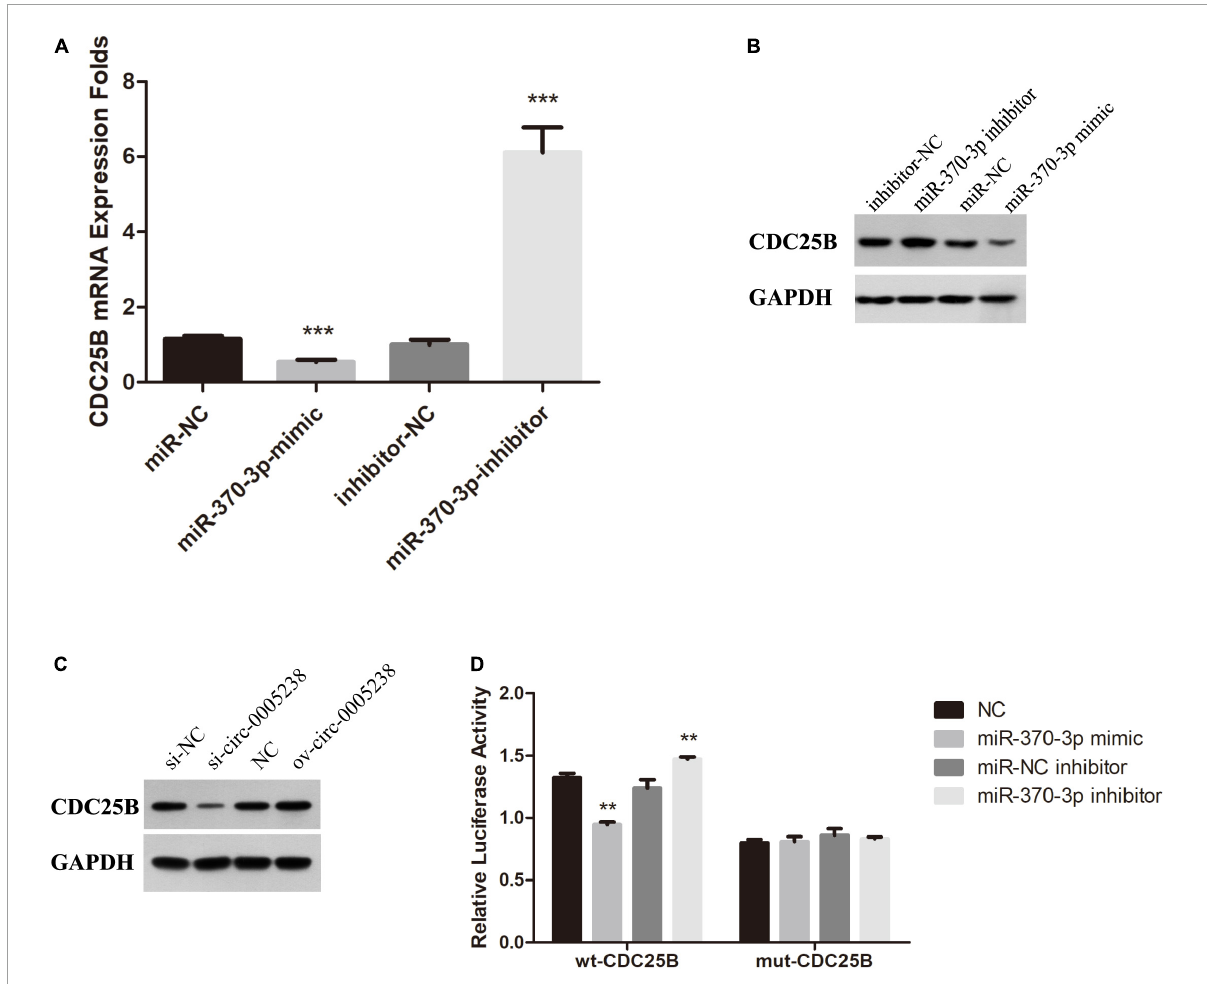
FIGURE9 CDC25B is a direct target of miR-370-3p. (A) Expression of CDC25B in miR-370-3p-mimic, miR-NC, inhibitor- miR-370-3p and inhibitor-NC group by RT-qPCR. (B) Western Blot results of CDC25B expression in miR-370-3p-mimic, miR-NC, inhibitor- miR-370-3p and inhibitor-NC group. (C) Western Blot results of CDC25B expression in si-circ-0005238, si-NC, ov-circ-0005238 and NC group. (D) Results of the dual luciferase activity assay. ** P < 0.01, *** P <